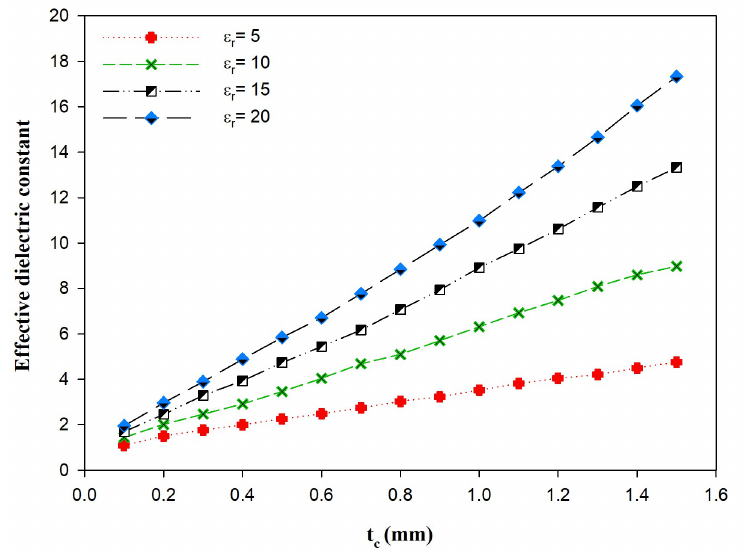
Figure 16. The effective permittivity of perforated hemispherical